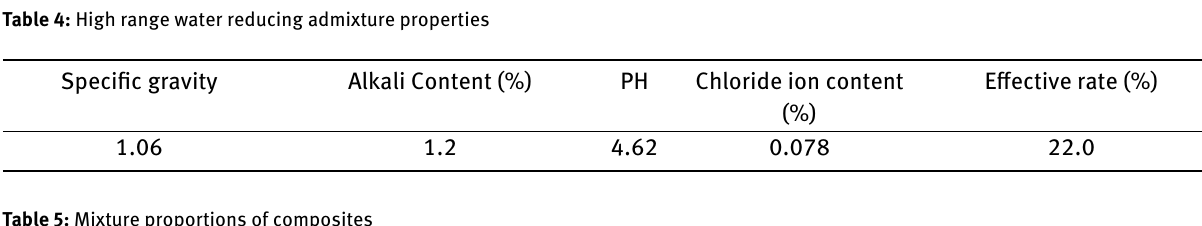
Table 5: Mixture proportions of composites